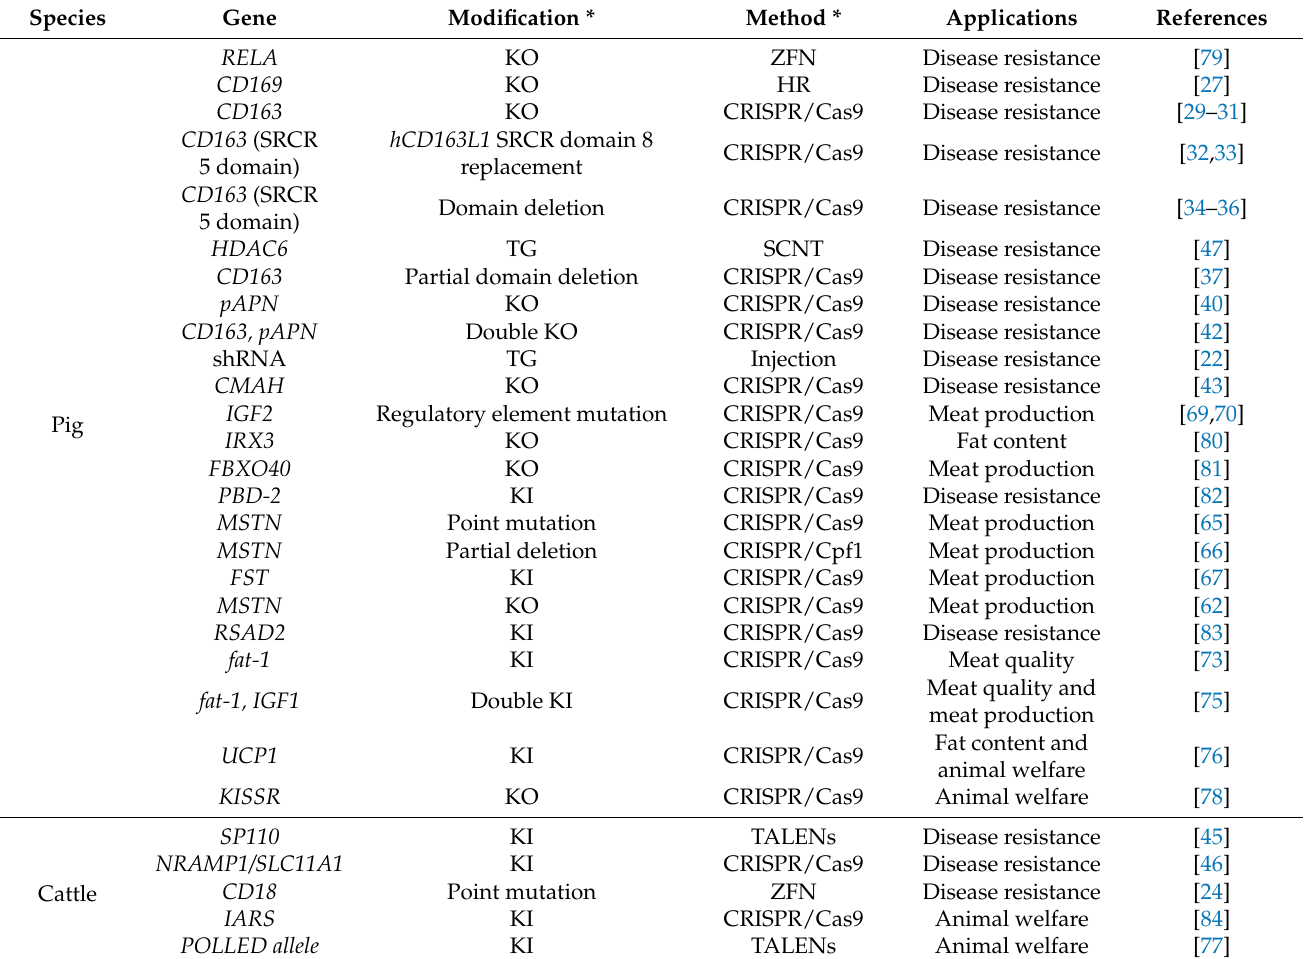
Table 1. List of genome-edited livestock